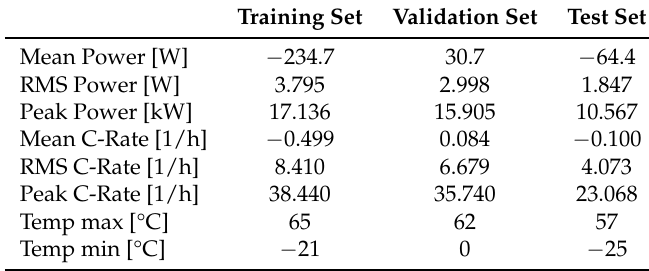
Table 1. Power, C-rate and temperature values for the three created datasets: training set, validation set and test